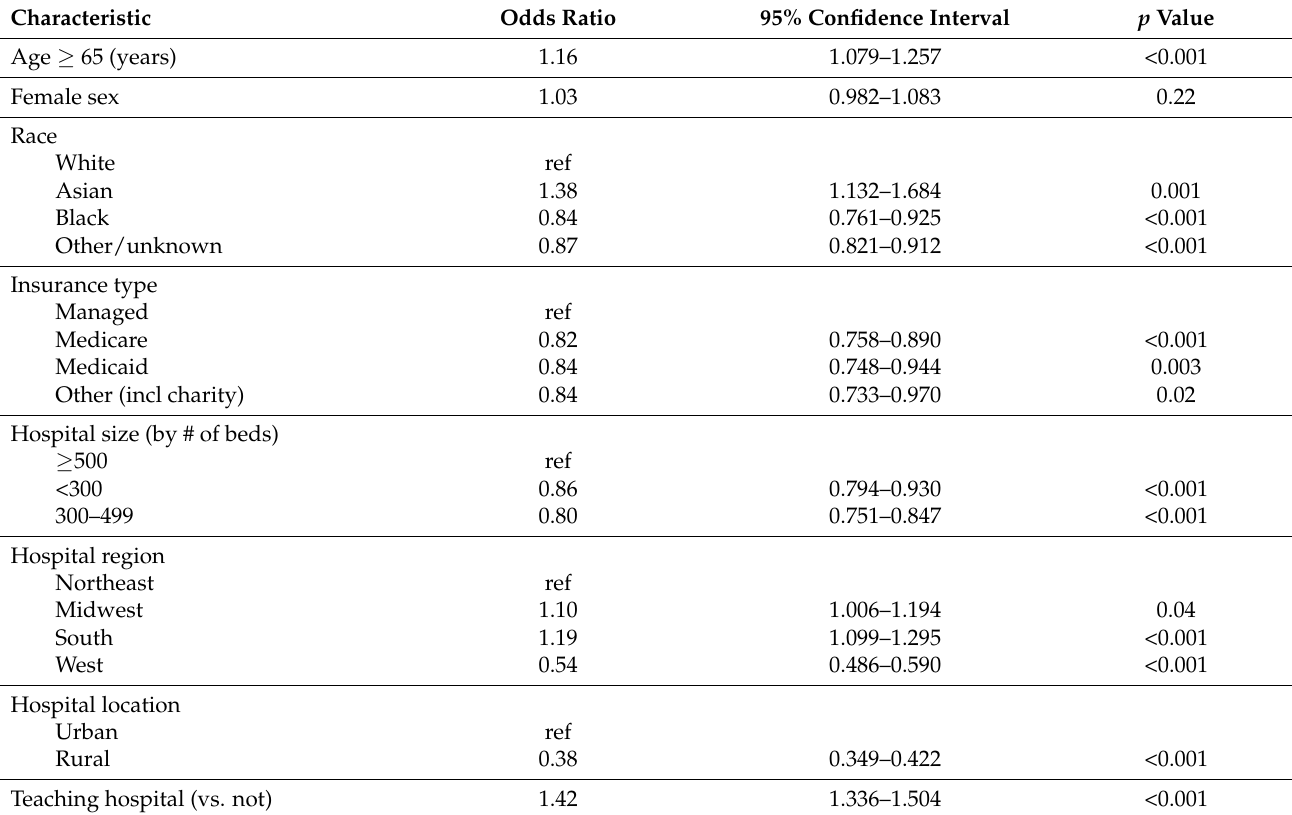
Table 2. Multivariable logistic regression analysis of factors associated with patients receiving lung lobectomy from a thoracic surgery provider in the Premier Healthcare Database from 2009 to 2019.